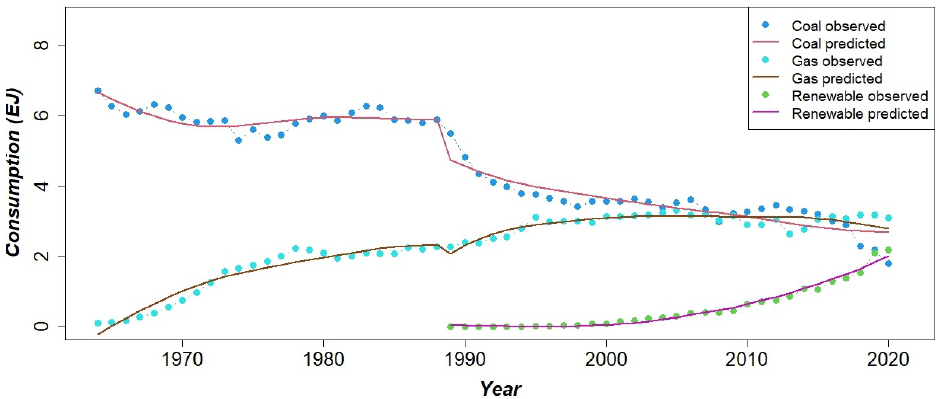
Figure 3. UCTT model for coal, natural gas, and renewables in Germany from 1964 to 2020. The model obtained a satisfactory result in terms of goodness-of-fit ( R 2 = 0.9903495) and significance of parameters as a general outcome. Parameter estimates are outlined in Table